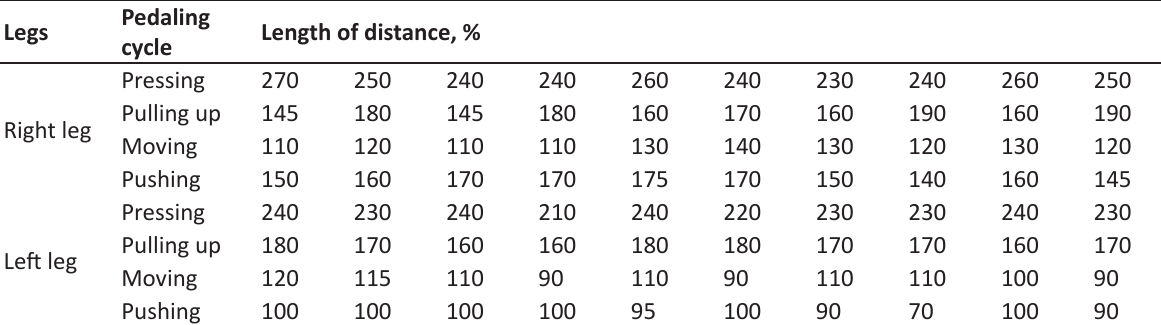
Table 3. Dynamic of maximal forces in pedaling cycle of elite cyclists on model pursuit racing, H Legs